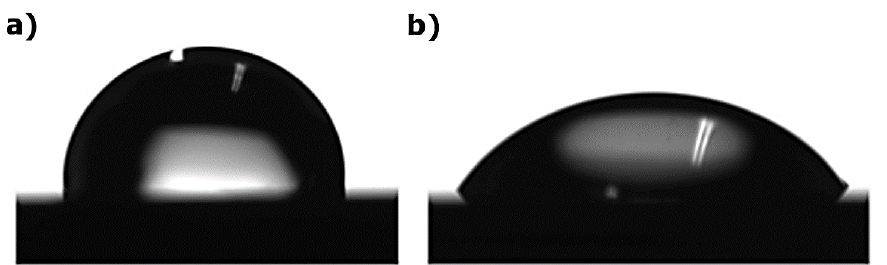
Figure A1. AFM height micrographs of SbpA films assembled in the presence of either CaCl 2 (left) or FeCl 3 (right), which act as positive or negative control images, respectively. Insets show the resulting Fourier spectra analysis from the respective images. Scale bars = 200 nm.